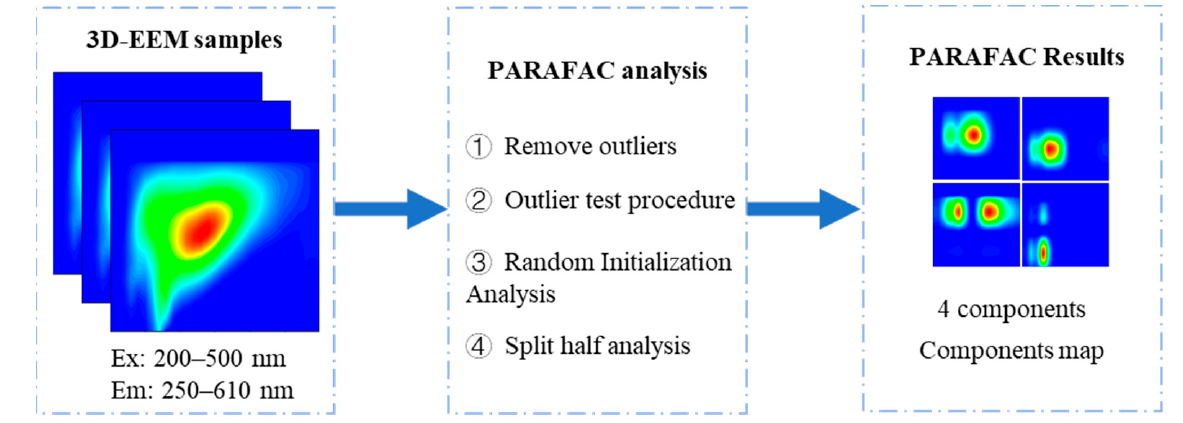
Figure 7. PARAFAC analysis process and result (taking FU dataset as an example).